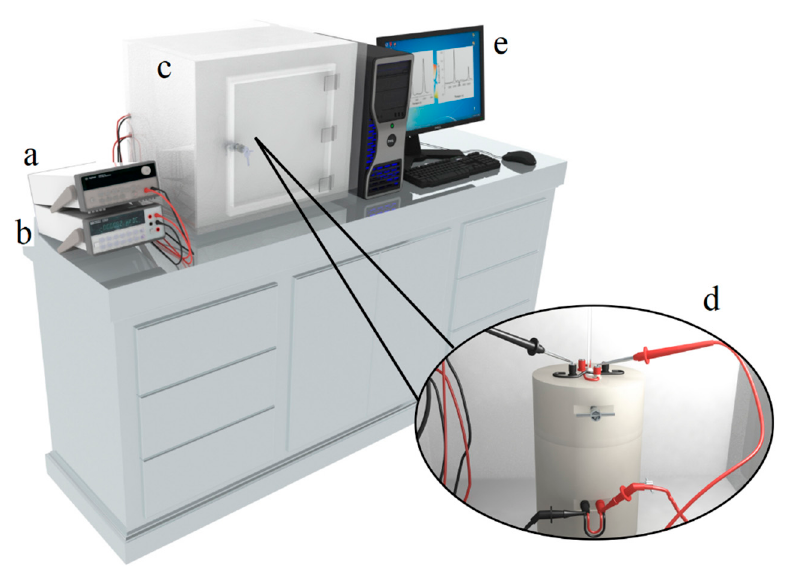
Figure 1. Immersion calorimeter design. The diagram shows: ( a ) the multimeter, ( b ) amperimeter, ( c ) compartment where the calorimeter is located isolated from the surroundings, ( d ) a zoom that shows the calorimeter, ( e ) computer that registers the calorimetric signals.